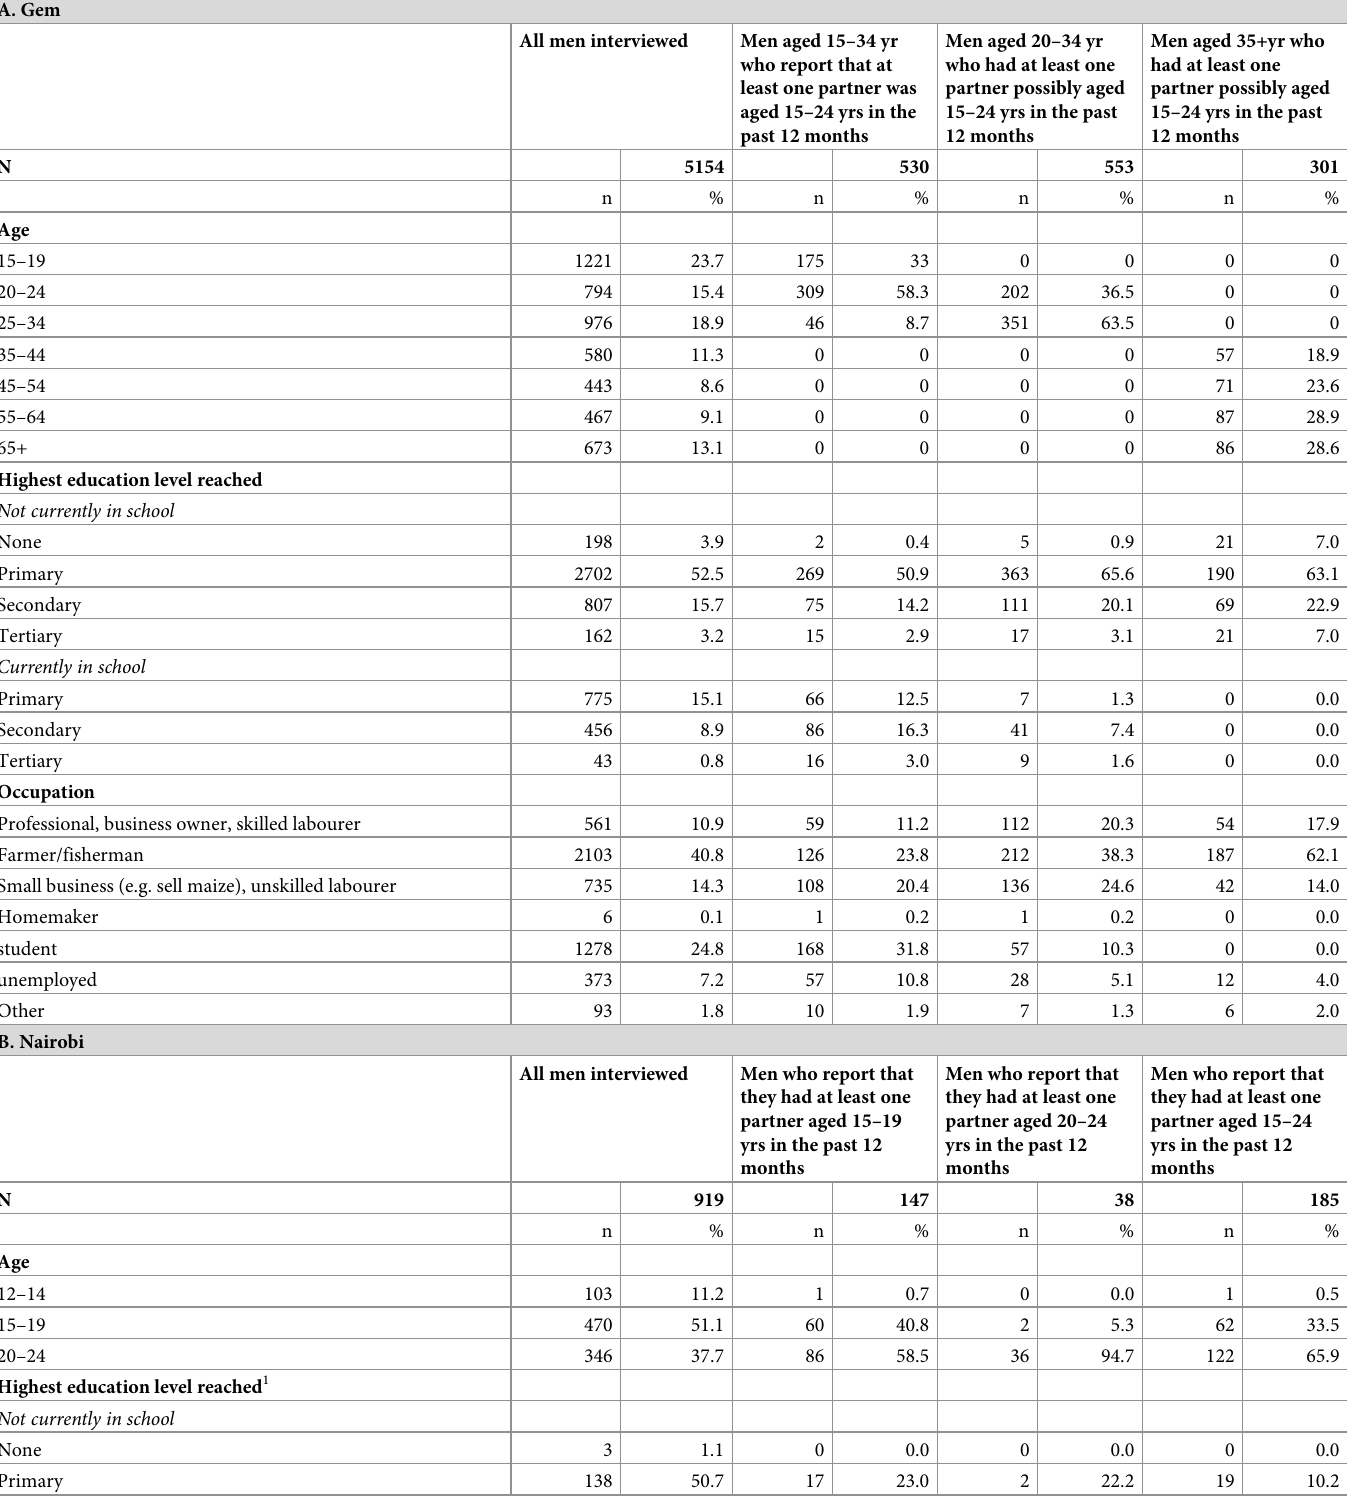
Table 1. Demographic characteristics of males who report a partner aged 15–24 years in the past 12 months (based on last 3 partners, source: male interviews). A.